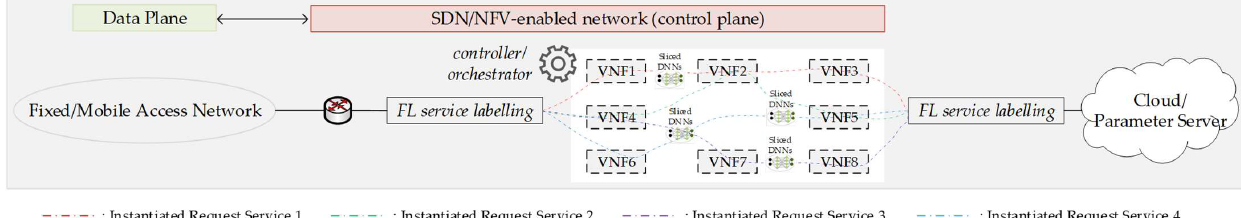
Figure 6. SDN-assisted control architecture for distributing DNNs.